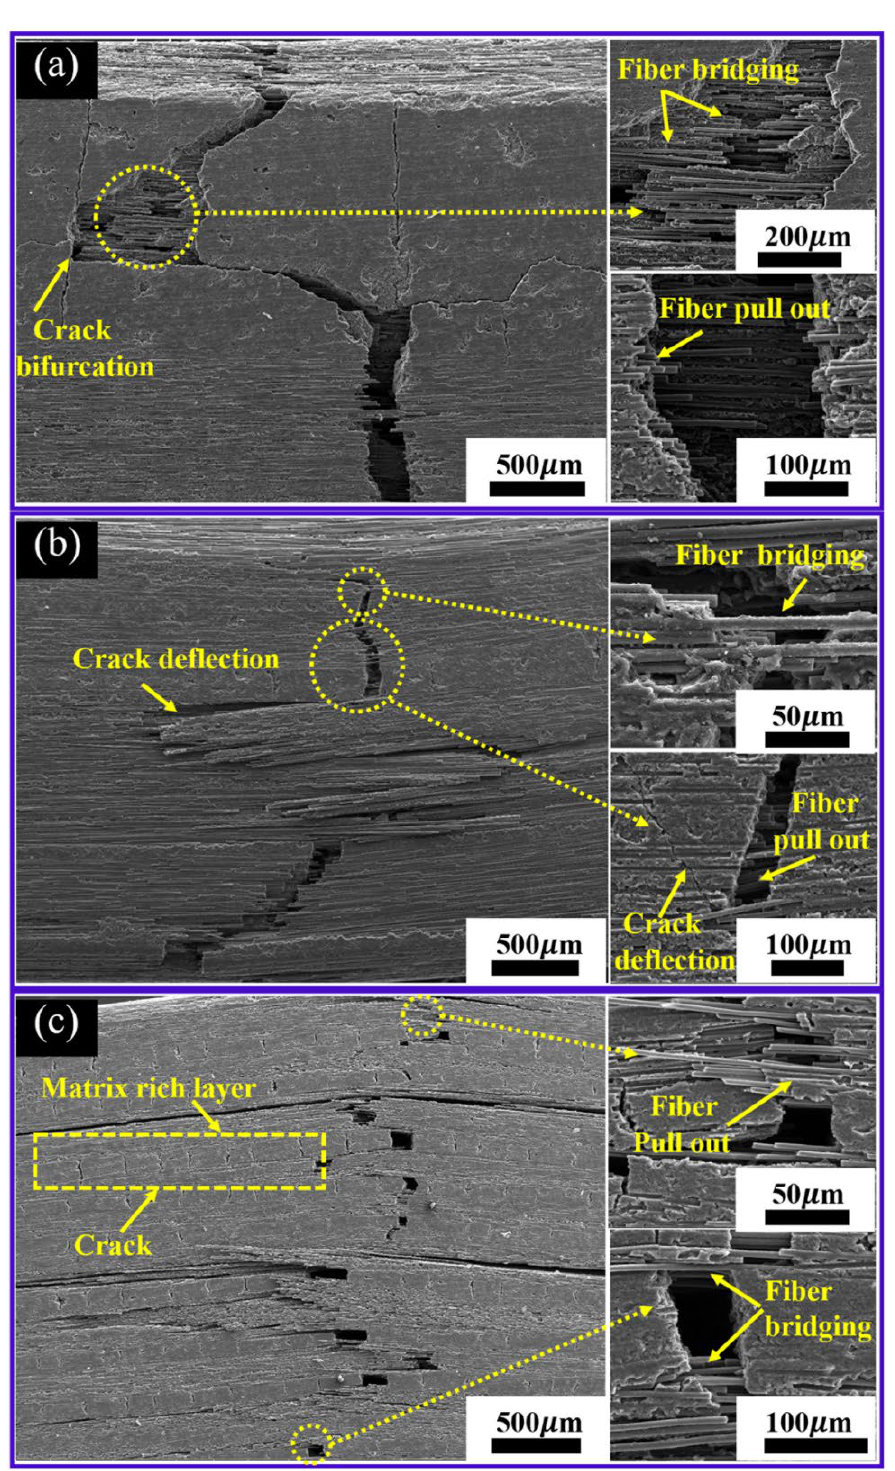
Figure 8. SEM images showing the crack patch of flexural tested composites: ( a ) Cf/C-SiC-50% composite; ( b ) Cf/C-SiC-60% composite; ( c ) Cf/C-SiC-70% composite.